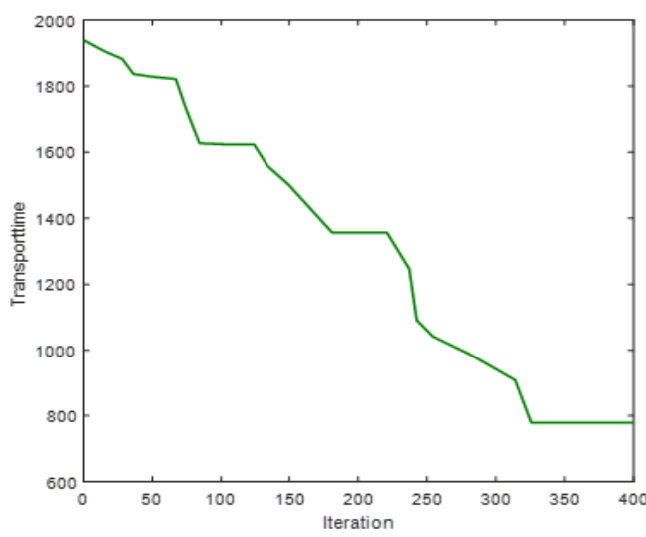
Figure 17. Time target iteration curve of EGA